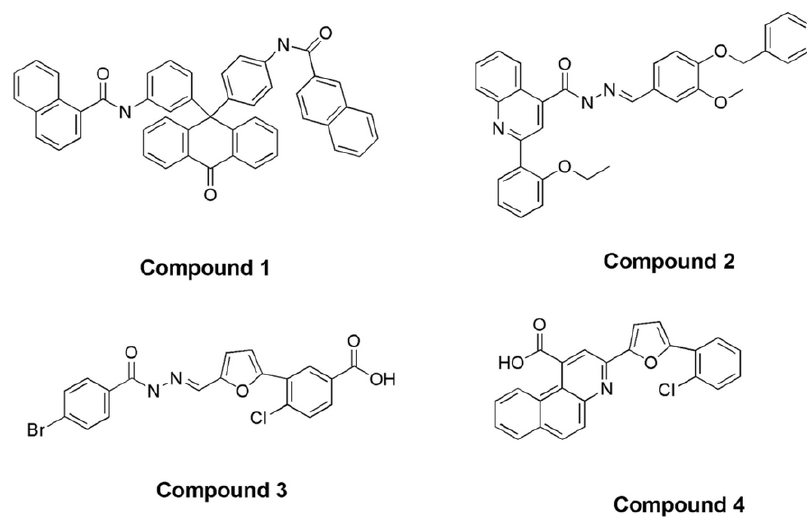
Figure 3. The chemical structures of four compounds as potential PhoQ inhibitors.